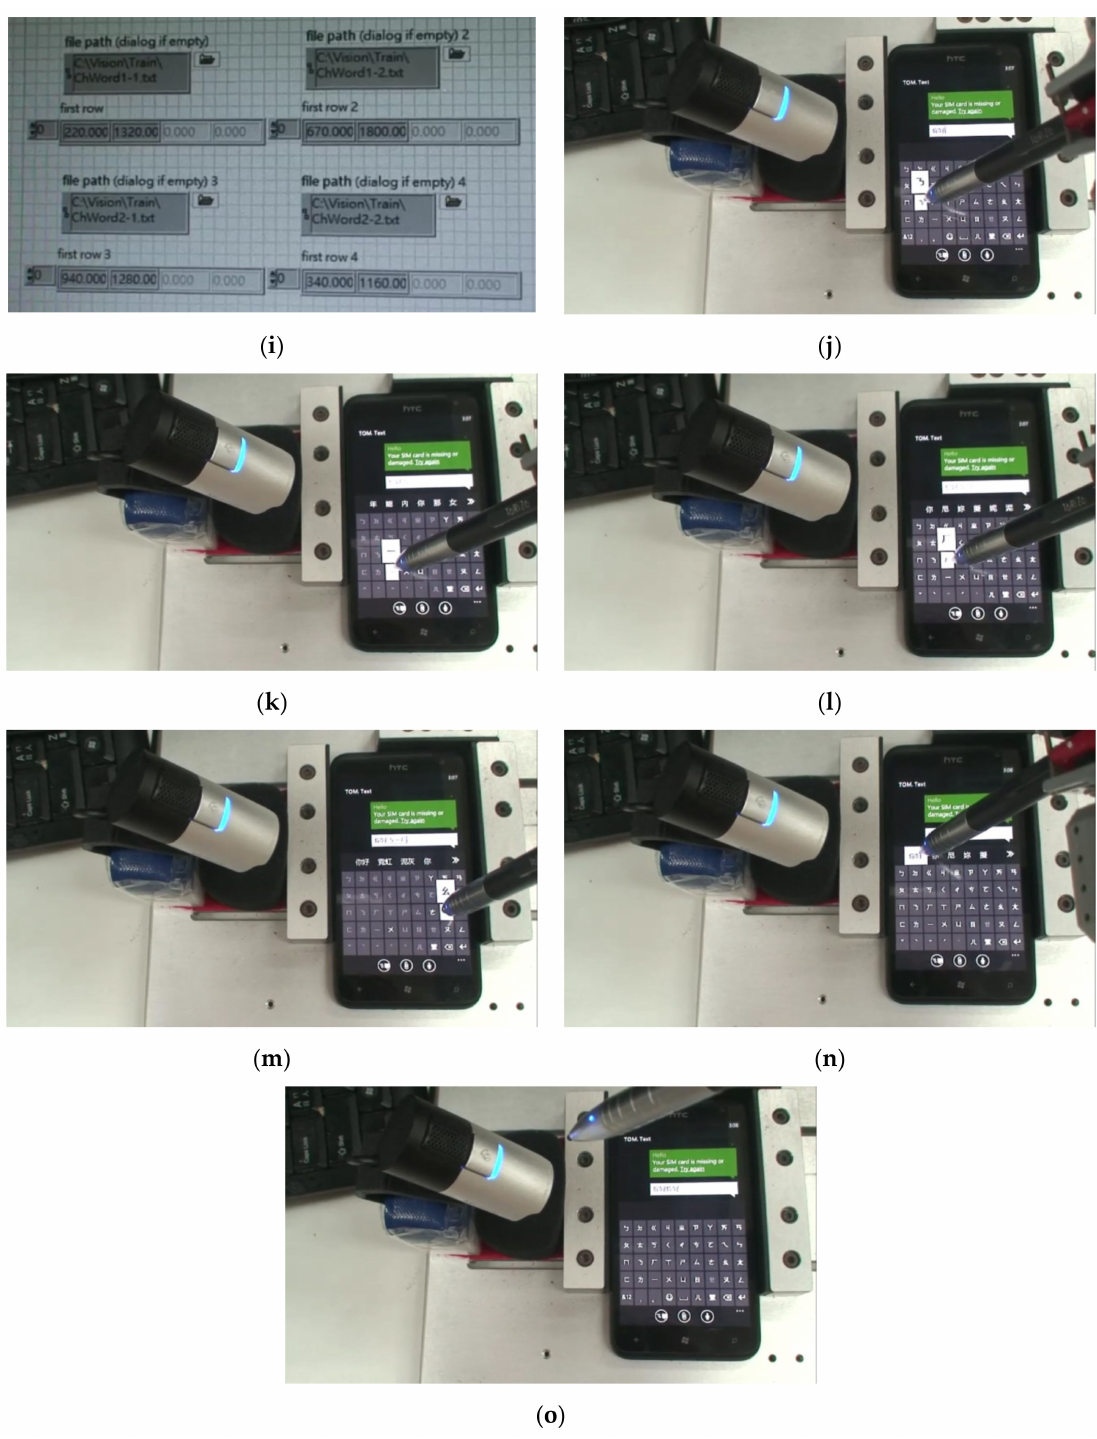
Figure 28. Automatically updating coordinate information. ( a ) Press symbol “ ㄋ ”. ( b ) Press symbol “ ㄧ ”. ( c ) Press symbol “ ㄏ ”. ( d ) Press symbol “ ㄠ ”. ( e ) Press characters “ 你 好 ”. ( f ) Prepare to move camera. ( g ) Move camera. ( h ) The original coordinate information. ( i ) The latest coordinate information. ( j ) Press symbol “ ㄋ ” again. ( k ) Press symbol “ ㄧ ” again. ( l ) Press symbol “ ㄏ ” again. ( m ) Press symbol “ ㄠ ” again. ( n ) Press characters “ 你 好 ” again. ( o ) Confirm